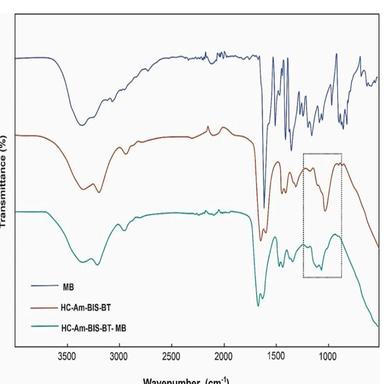
FTIR-ATR spectrum of HC-g-Am-1-BIS-BT before and after HC-g-Am-1-BIS-BT-MB contacting with MB.